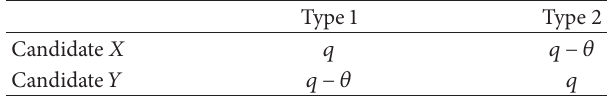
Table 1: Payoffs